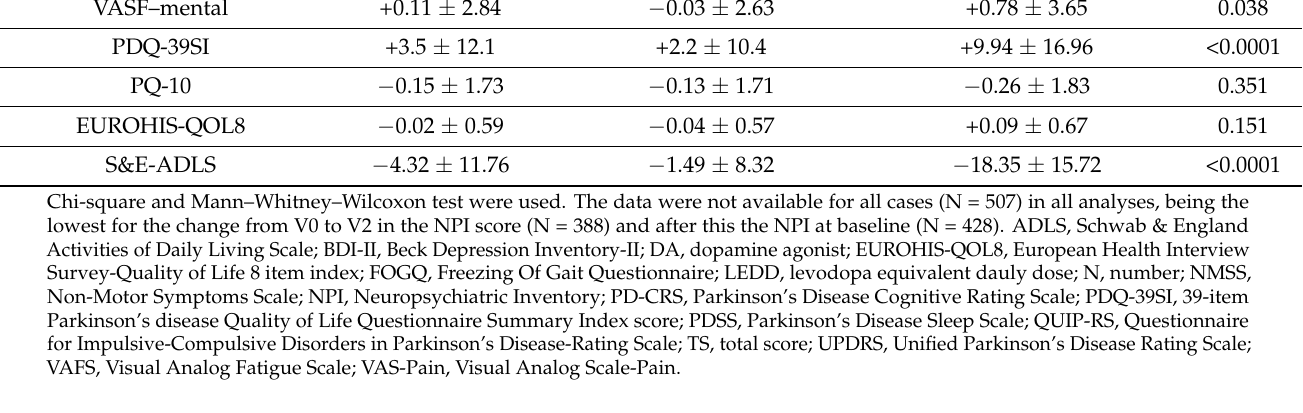
Table 3. Linear regression model about factors associated with disability progression after 2-year follow-up (change in the S&E-ADLS score at V2 compared to at V0).